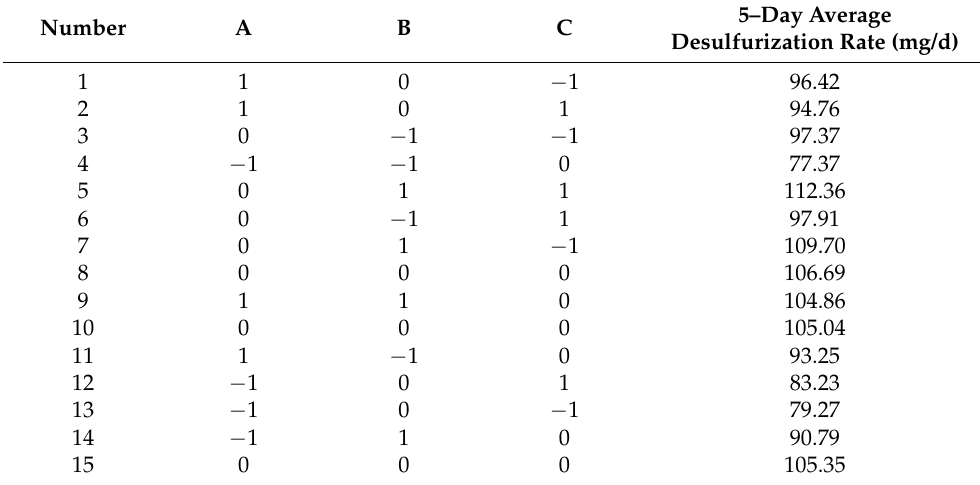
Table 8. Results of the Box–Behnken experiment.